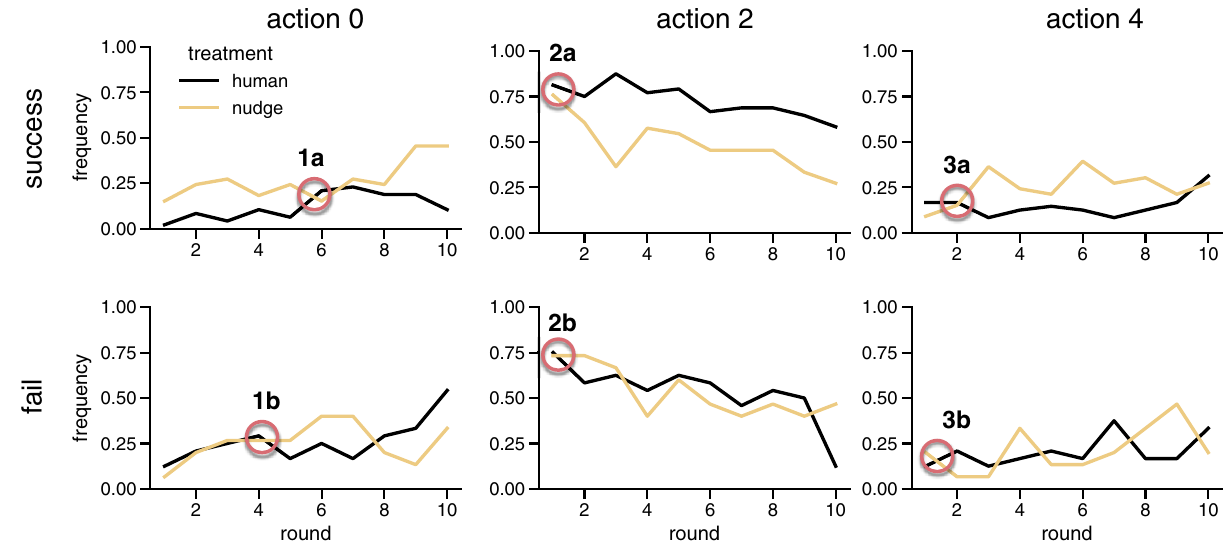
Figure 3. Frequency of each possible action over the 10 experimental rounds for successful and failed groups. The subplots display the frequency of the contributions (0, 2 or 4) made by human participants over the 10 rounds of the game separated for successful and failed groups. The subplots in the second column show that in both the humans (black lines) and nudge (yellow lines) treatments, independent of whether the group was successful or not in reaching the target, participants are inclined towards contributing 2 EMUs in the first round (points 2a and 2b). Also, in both treatments, there is a decreasing trend in the frequency of action 2. The first column indicates that there is a slight increase in the frequency of action 0 in the nudge treatment with respect to the human control (points 1a and 1b). Finally, the third column shows that, in successful groups, participants in the nudge treatment contribute 4 EMUs more frequently than in the humans treatment after round 2 (point 3a). This is not true for the unsuccessful groups (point 3b) where we observe that the frequency of this action oscillates.